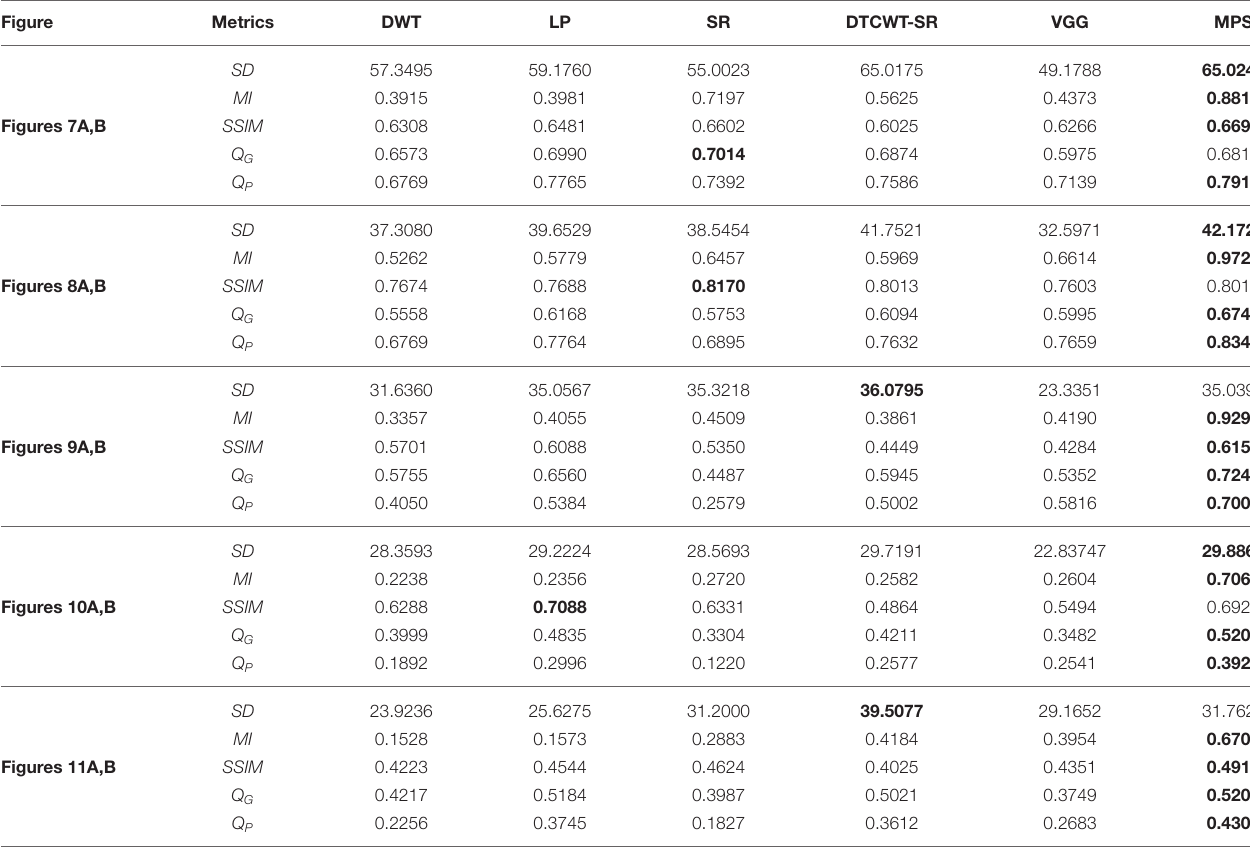
TABLE 4 | Comparison of objective evaluation metrics of infrared and visible images.